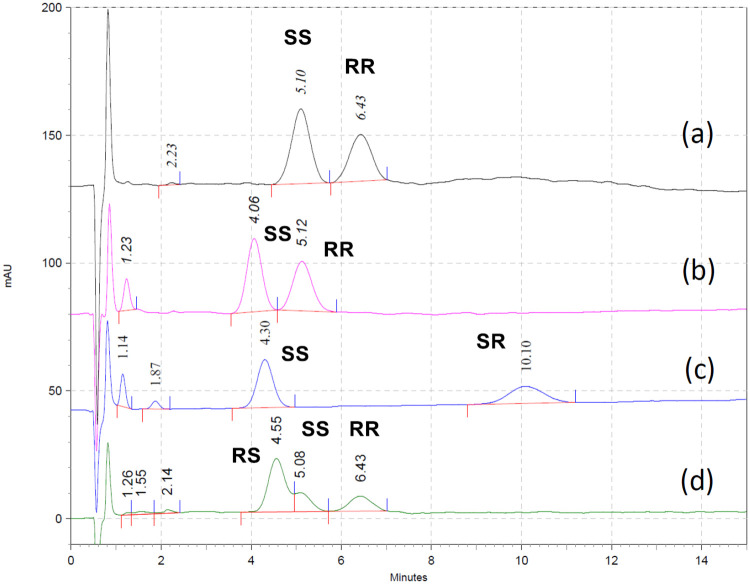
Chiral HPLC chromatograms.Using Chirex 3126 column: 30 mm × 4.6 mm; mobile phase: IPA:2 mM CuSO4 = 15:85. a) (2S,4S)-1 and (2R,4R)-1, at 23°C; b) (2S,4S)-1 and (2R,4R)-1, at 26°C; c) (2S,4S)-1 and (2S,4R)-1, at 26°C; d) (2R,4S)-1, (2S,4S)-1 and (2R,4R)-1, at 23°C.